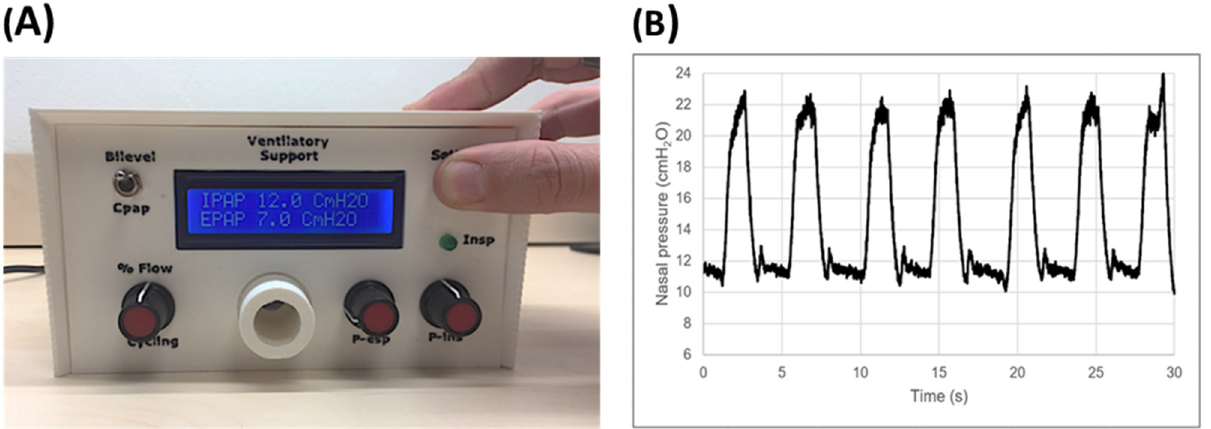
Figure 5. ( A ) Front view of the low-cost ventilator prototype. ( B ) Example of pressure signal recorded when the prototype ventilator supported a resistive–restrictive loaded breathing volunteer’s breathing. These are unfiltered raw data from the sensor within the ventilator. Reprinted with permission from Ref. [11] . Creative Commons CC-BY license.